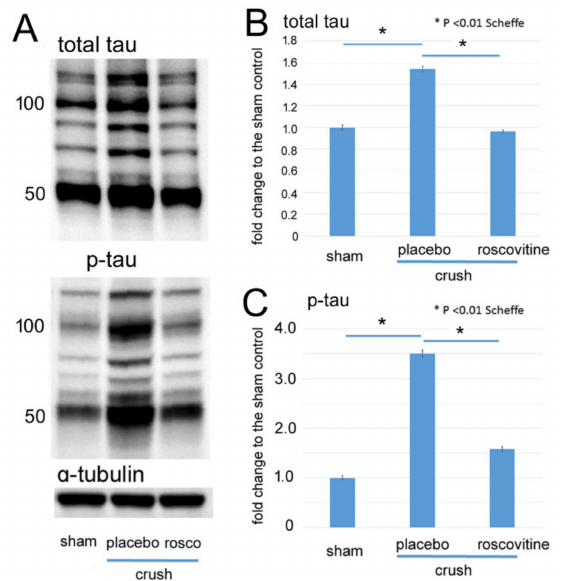
Figure 1. Western blots for phosphorylated tau in the retina after ONC. ( A ): Representative protein bands of total and phosphorylated (ser 396) tau in extracts from the retina on day 3 after ONC. α -tubulin was used as internal control. ( B , C ): Levels of total ( B ) and phosphorylated tau ( C ) in 50-kDa bands are shown as fold changes (means ± SD) relative to the sham control. Both levels significantly increase in the retina after ONC (placebo) from the sham control, while roscovitine reduced the increases. (* p < 0.01, Scheffe; n = 3 for each